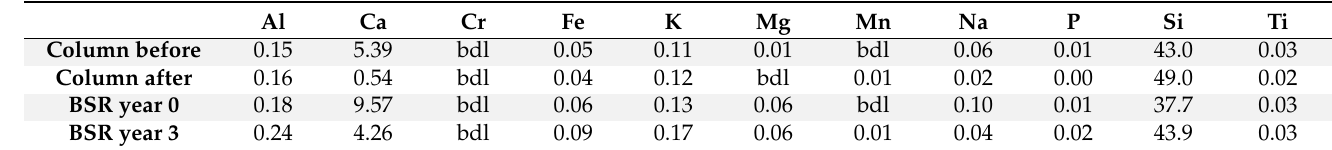
Table 3. Average major elemental composition (% wt.wt) of the raw sand determined using X ray diffraction (n = 4).